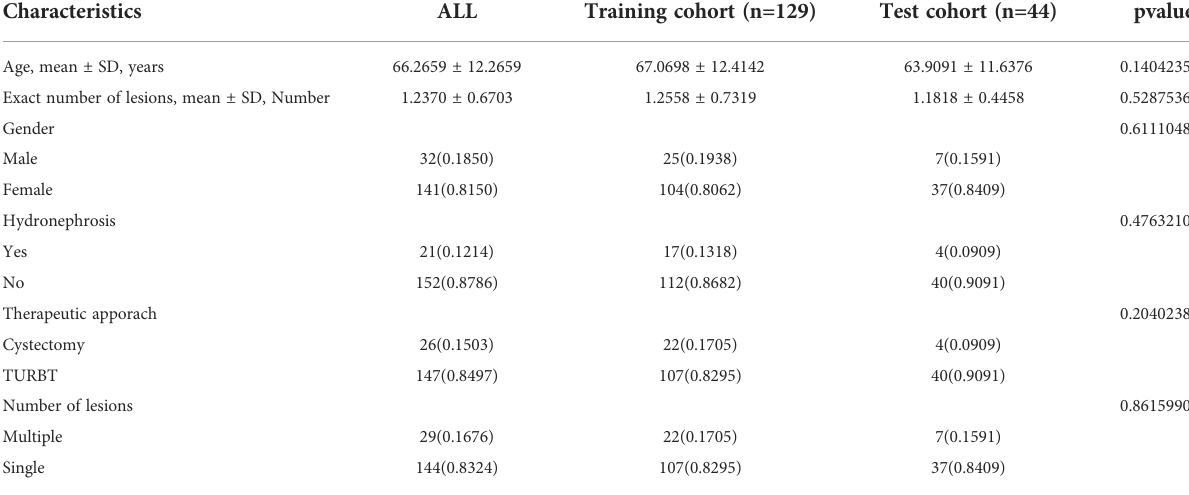
TABLE 2 Clinical characteristics of Bca patients in the training and test sets.